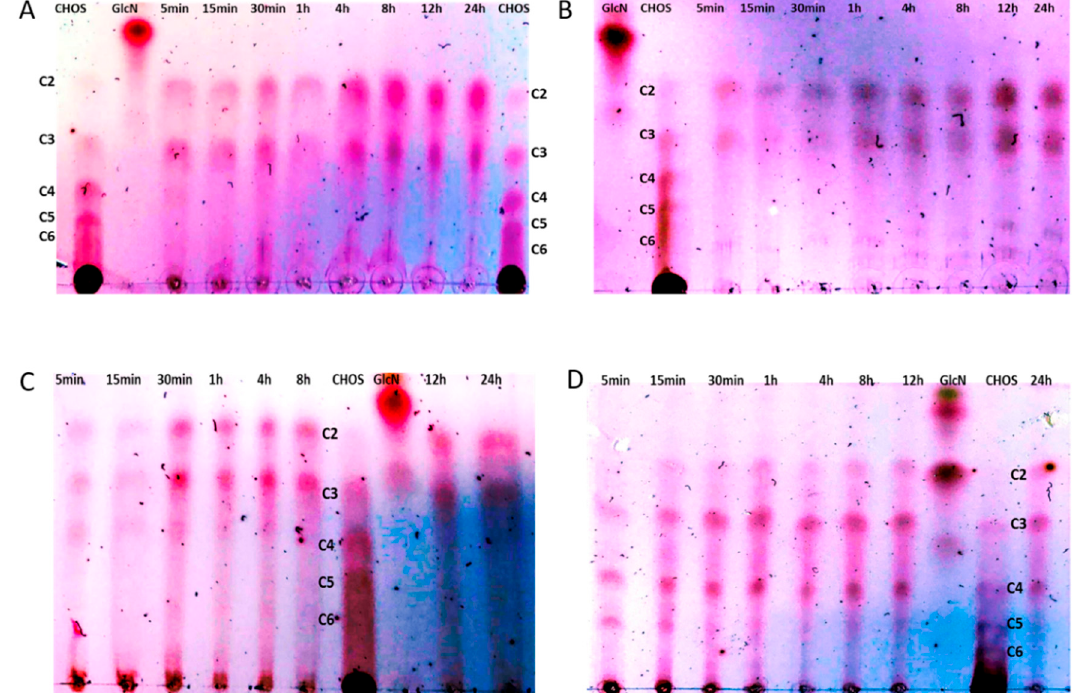
Figure 6. Formation of chito-oligosaccharides (CHOS) from chitosan (0.5% w/v) by chitosanase-displaying L. plantarum cells harboring p alr Lp0373_CsnA_L at 37 °C ( A , B ) and 50 °C ( C , D ) using two different substrates: chitosan low molecular weight ( A , C ) and chitosan from crab shells medium molecular weight ( B , D ) as analysed by thin layer chromatography (TLC). Standards: commercial chito-oligosaccharides (TCI Deutschland GmBH, Eschborn, Germany) which contains chitobiose ( C2 ), chitotriose ( C3 ), chitotetraose ( C4 ), chitopentose ( C5 ), chitohexaose ( C6 ) and D -glucosamine (GlcN).